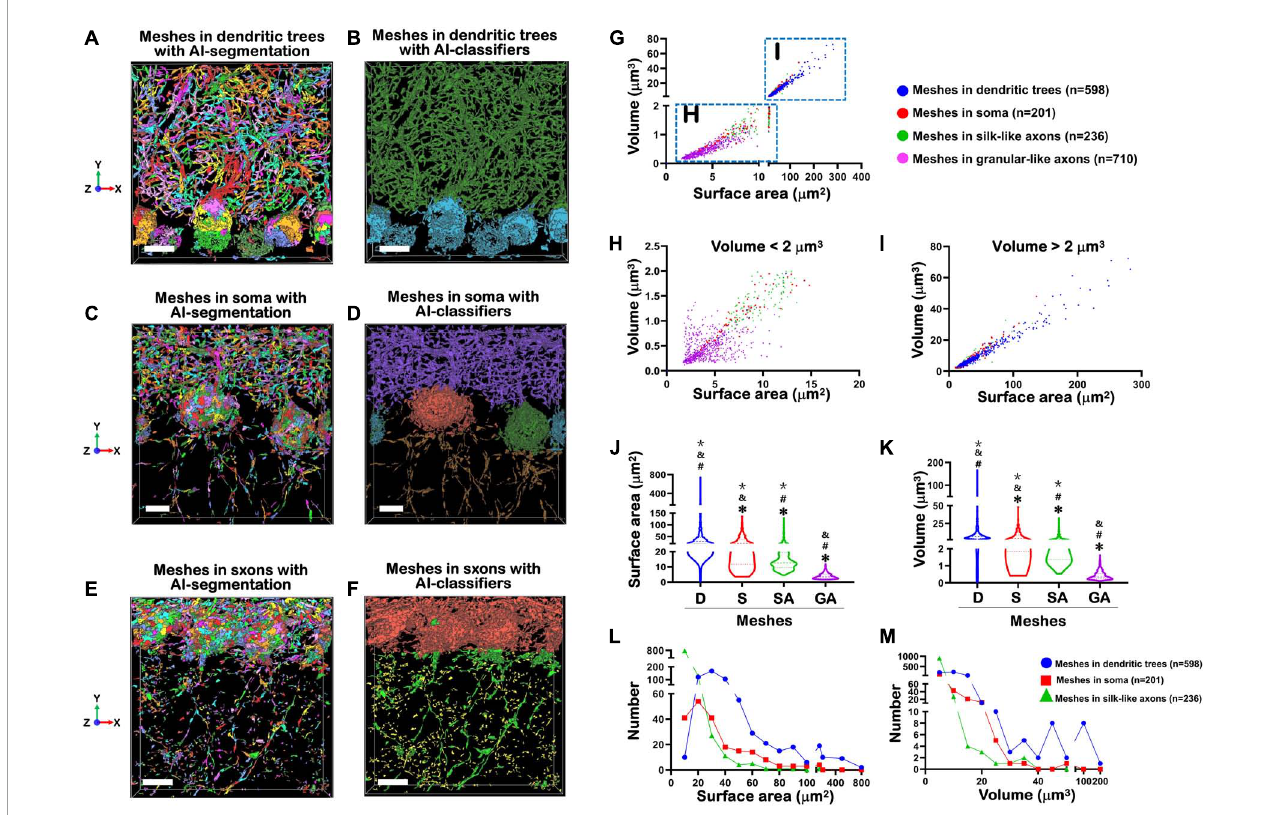
FIGURE4 Treatment of MNs by AI-powered segmentation and classifiers. (A) Showed after Aivia’s AI-powered segmentation but without classifiers, the MNs in the dendritic trees of PCs were transformed to colorful meshes. These images were corresponding to Figures 3A–C . Difference of colors did not indicate the difference of size, but only represented the segmentation of different meshed. The total number of mitochondrial meshes was 598. Bar = 10 µ m. (B) After treatment by Aivia’s AI-powered classifiers, all 598 mitochondrial meshes in the dendritic trees of PCs were given a dark green pseudo-color. Bar = 10 µ m. (C) After Aivia’s AI-powered segmentation but without classifiers, the MNs in the soma of PCs were transformed to colorful meshes. These images were corresponding to Figures 2F , 3D . The total number of mitochondrial meshes was 201. Bar = 5 µ m. (D) After treatment by Aivia’s AI-powered classifiers, all 201 mitochondrial meshes in the soma of PCs were given orange, or dark green, or lake color pseudo-color. Bar = 5 µ m. (E) After Aivia’s AI-powered segmentation but without classifiers, the MNs in the axons of PCs were transformed to colorful meshes. These images were corresponding to Figures 3G–I . It should be indicated that the MNs in the axons could be divided into two types: one type was named as silk-like axons because the mitochondrial meshes connected to each other and formed a long liner line going through the GCL; another type was named as granular-like axons because the mitochondrial meshes distributed as an isolated island and they did not connect each other. The total number of silk-like mitochondrial meshes in axons was 236, while the total number of granular-like mitochondrial meshes in axons was 710. Bar = 10 µ m. (F) After treatment by Aivia’s AI-powered classifiers, all 236 silk-like mitochondrial meshes in the axons were given green pseudo-color, while all 710 granular-like mitochondrial meshes in the axons were given yellow pseudo-color. Bar = 10 µ m. (G) The relationship of surface area and volume of all 1,745 mitochondrial meshes, including in granular-silk axons (pink), in dendritic trees (blue), in soma (red) and in silk-like axons (green), showed near-linear correlations. (H) The relationship of surface area and volume of the smaller mitochondrial meshes with the volume less than 2 µ m 3 . (I) The relationship of surface area and volume of the bigger mitochondrial meshes with the volume more than 2 µ m 3 . (J,K) The comparison of the surface area ( µ m 2 ) (J) and volume ( µ m 3 ) (K) in dendritic trees (D), soma (S), silk-like axons (SA) and granular-like axons (GA). The values of mitochondrial meshes in four groups showed statistically significantly. ∗ Compared to the number in dendritic trees group; # compared to the number in soma group. & Compared to the number in silk-like axons group. ∗ Compared to the number in granular-like axons group. (L,M) The relationship between the number of mitochondrial meshes in dendritic trees (blue ball), or in soma (red square), or in silk-like axons (green triangle), and corresponding surface area (L) or volume (M) . Yellow part indicated the distribution of the most number of mitochondrial meshes. Statistical analysis was performed by Kruskal-Wallis test. The data are shown as the mean ±